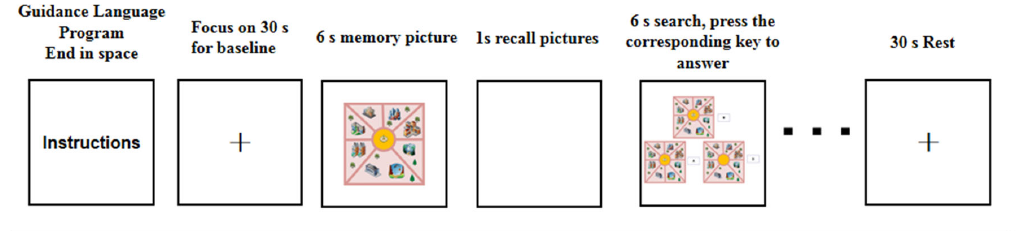
Figure 3. Experimental flow of spatial memory test.